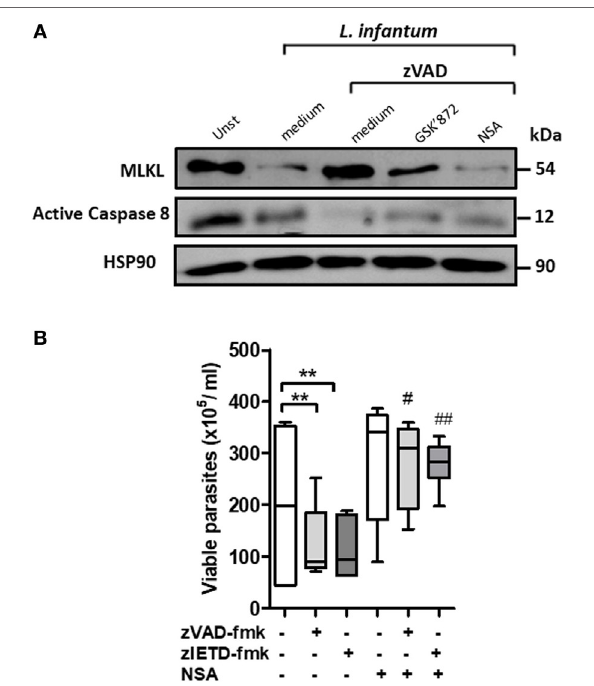
FigUre 3 | Inhibition of mixed lineage kinase domain-like (MLKL) reverses Leishmania infantum killing induced by blockage of caspase-8 in